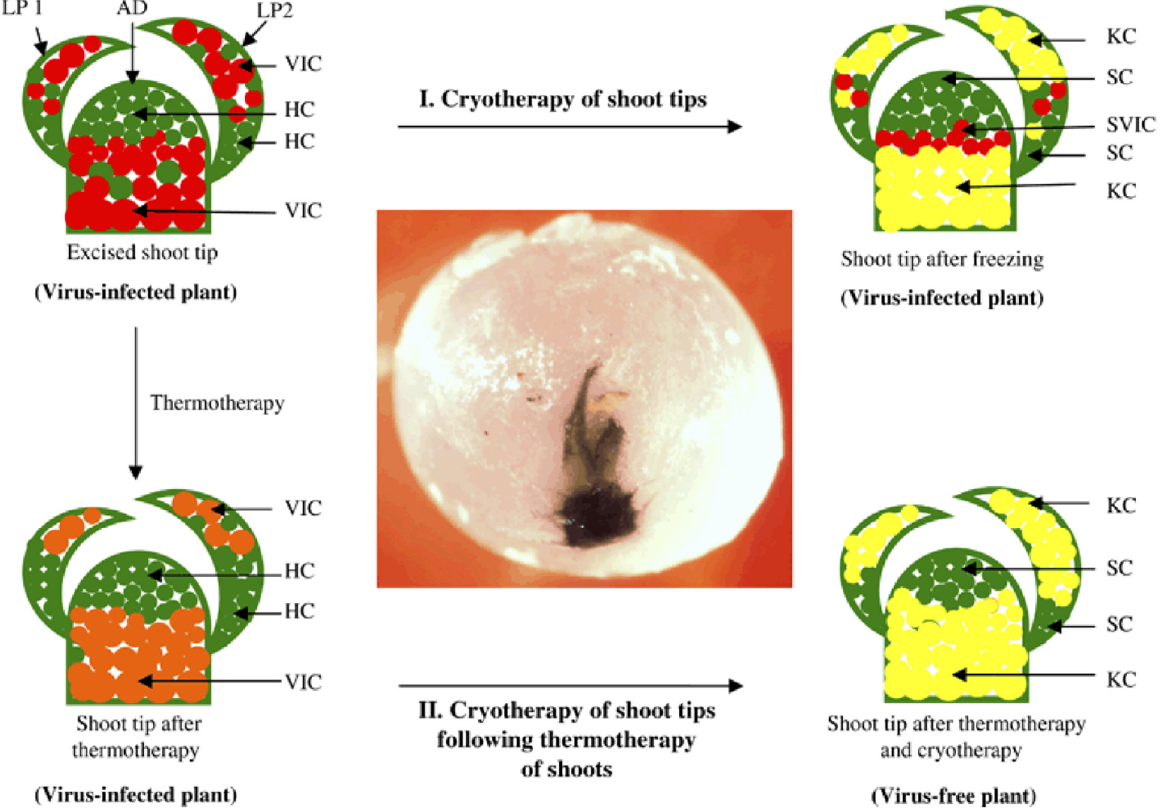
Figure 9. The schematic representation of combination of thermotherapy and cryotherapy for en- hanced elimination of pathogen ( C Las) that are capable of invading the meristematic cells. AD, apical dome; HC, healthy cells; KC, killed cells; LP1, leaf primordium1 (youngest); LP2, leaf primordium2; SC, surviving cells; SVIC, surviving, virus-infected cells; VIC, virus-infected cells [267].